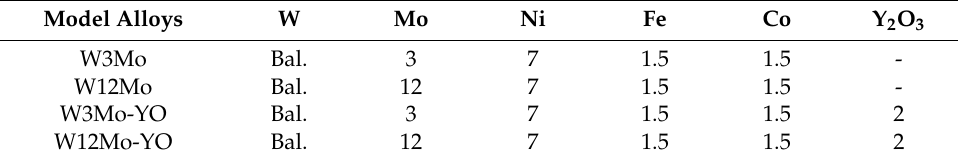
Table 1. The composition of the W-Mo-Ni-Fe-Co model alloys (wt.%). Model Alloys W Mo Ni Fe Co Y 2 O 3 W3Mo Bal. 3 7 1.5 1.5 - W12Mo Bal. 12 7 1.5 1.5 - W3Mo-YO Bal. 3 7 1.5 1.5 2 W12Mo-YO Bal. 12 7 1.5 1.5